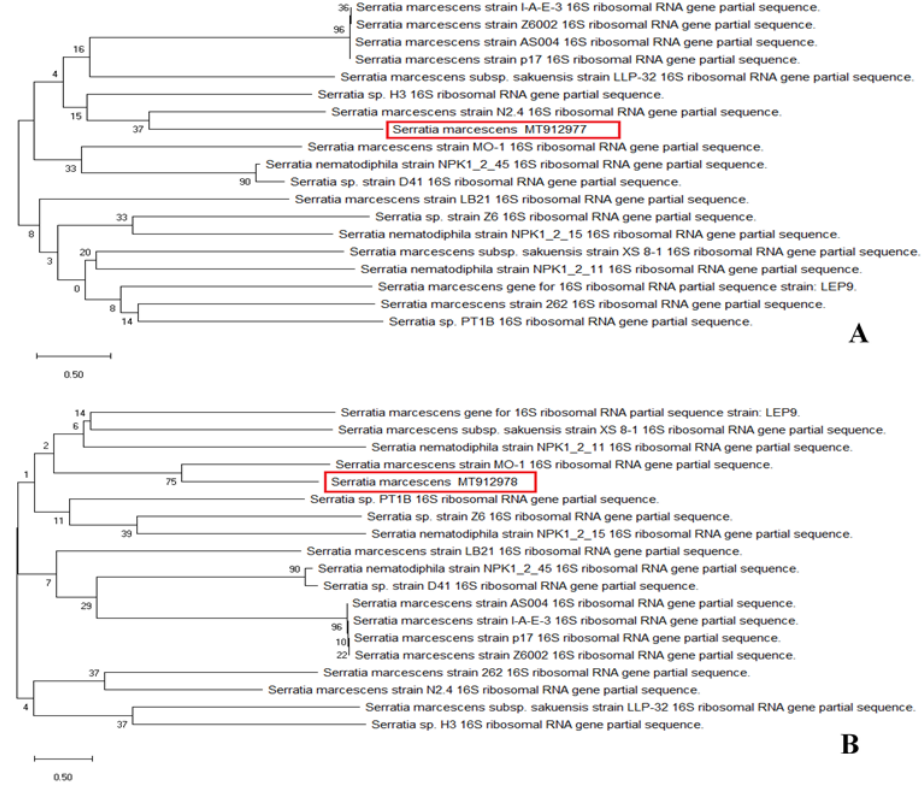
Figure 2. Evolutionary relationships of taxa. Phylogenetic tree of ( A ) BS1 and ( B ) BS2. The evolutionary history was inferred using the Neighbor-Joining method (Saitou & Nei, 1987). This analysis involved 21 nucleotide sequences. Codon positions included were 1st+2nd+3rd+Noncoding. There were a total of 1494 positions in the final dataset. The scale bar on the rooted tree indicates a 0.50 substitution per nucleotide position.